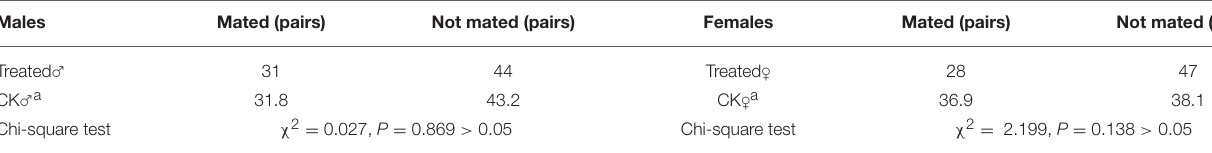
TABLE 4 | Mating competitiveness after irradiation treated on pupae.